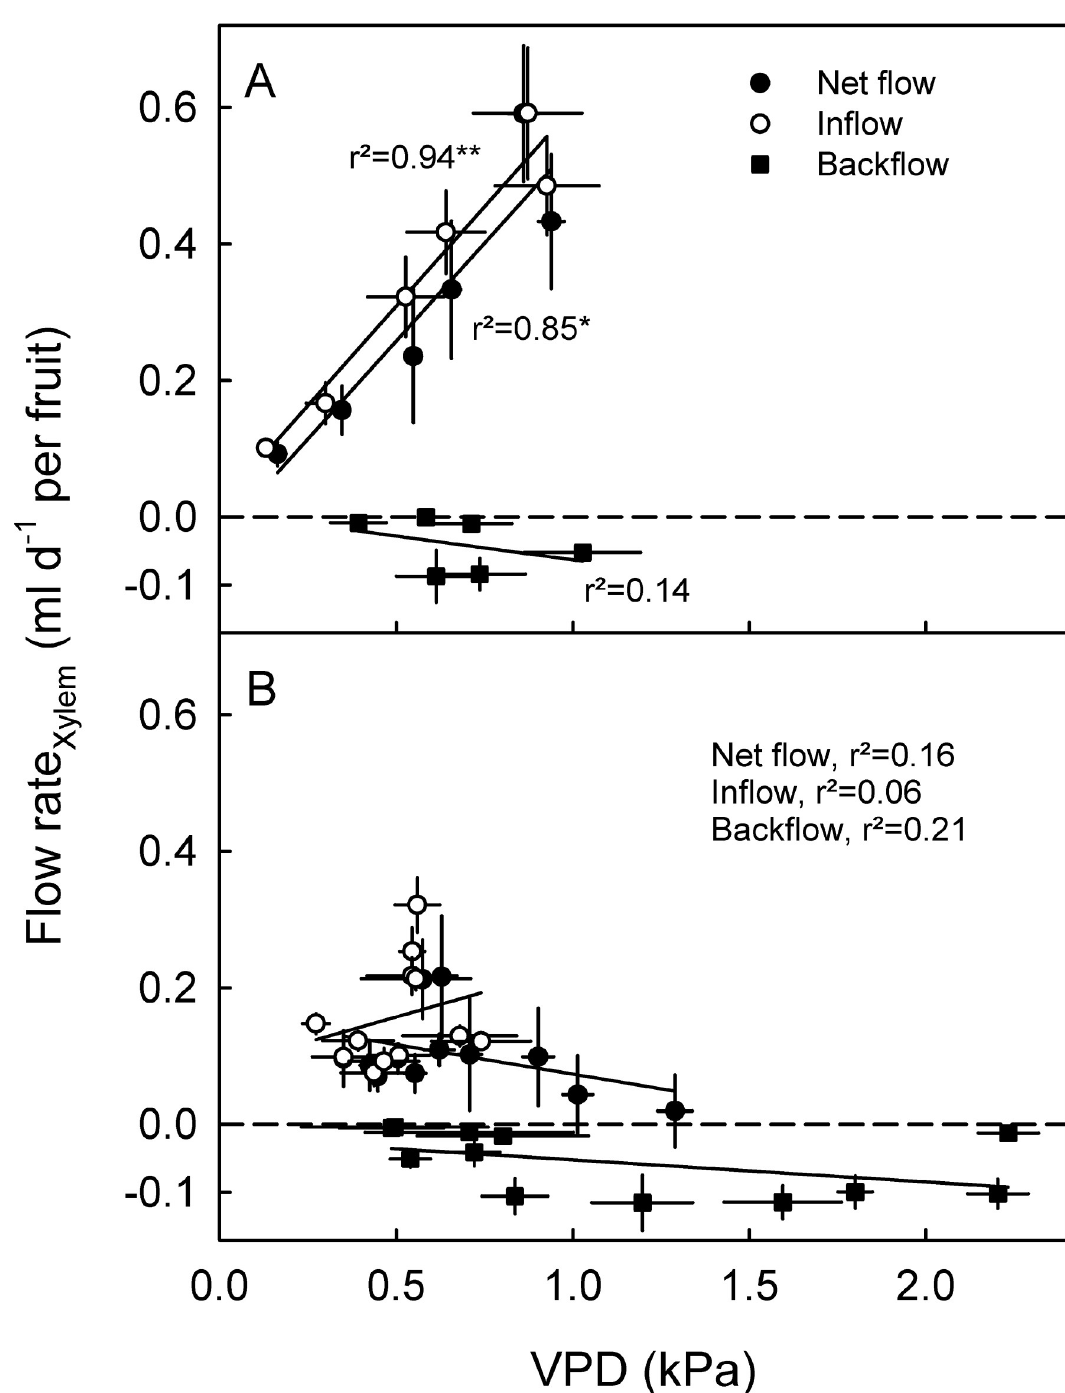
Fig 4. Daily total xylem inflow (positive), total xylem backflow (negative) and net daily xylem flow in stage II (A) and stage III (B) for European plum fruit as affected by atmospheric vapor pressure deficit (VPD). The net xylem flow was calculated as the algebraic sum of the total daily inflows plus the total daily backflows. Because fruit softening may slightly affect the measurement of fruit diameter change by a lightly spring-loaded linear variable displacement transducer, data for the last sampling period were not shown, as this is when fruit softening would have been most pronounced. Data represent means ±